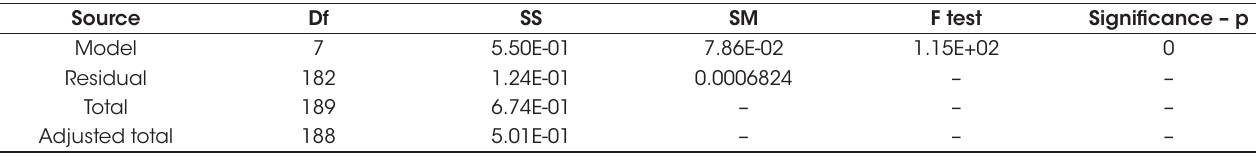
ANOVA of the shrinkage results